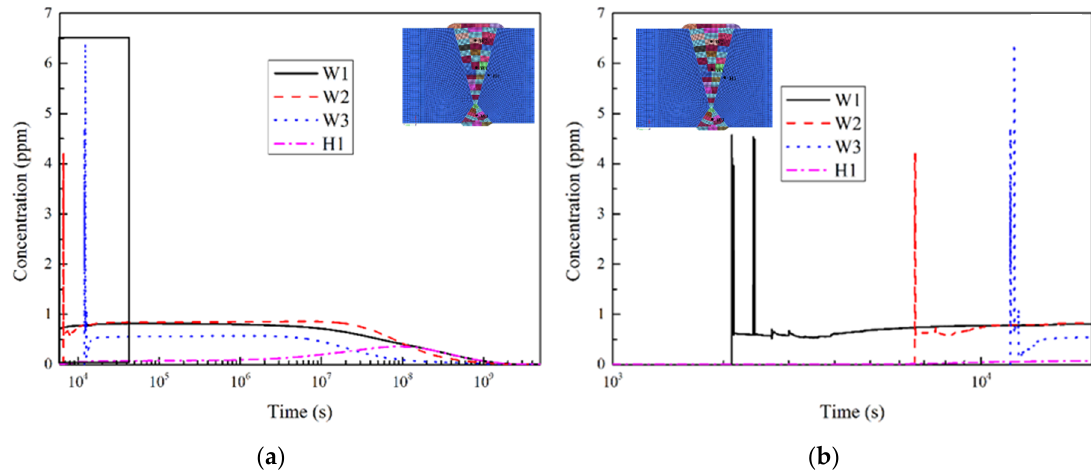
Figure 16. Concentration-time distribution curve of hydrogen of heavy plate welded joint: ( a ) Overall drawing; ( b ) Partial drawing.